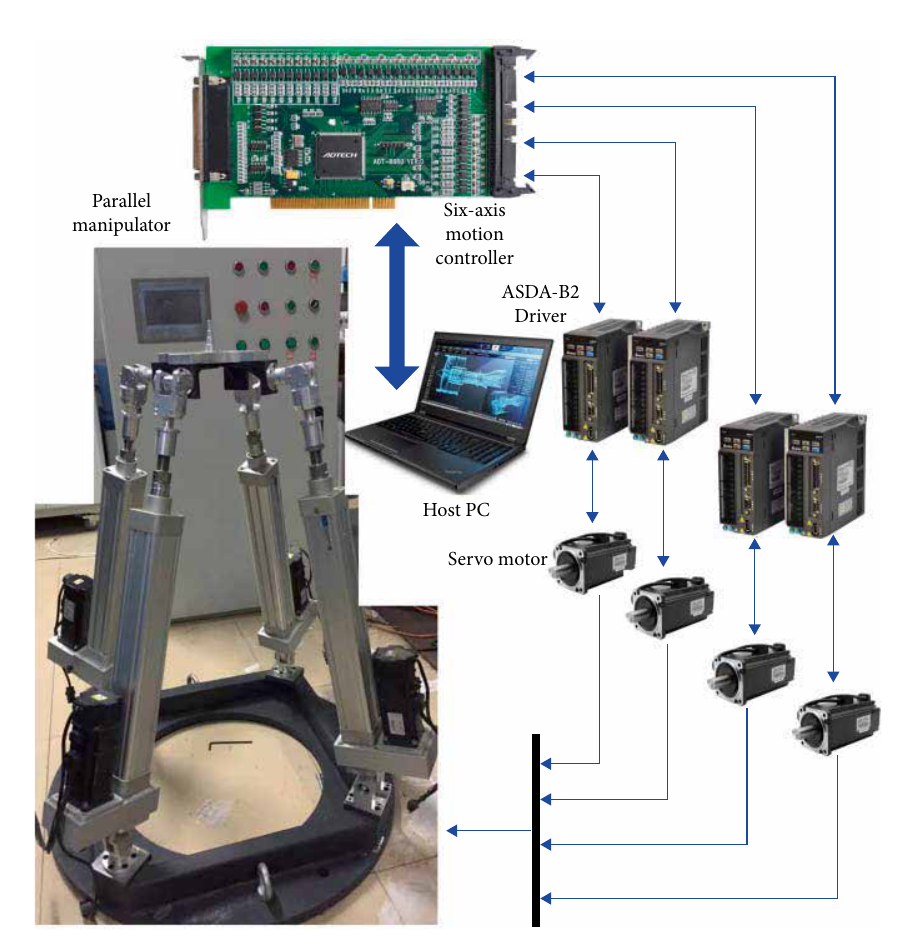
Figure 9: The experimental prototype of 3-DOF parallel